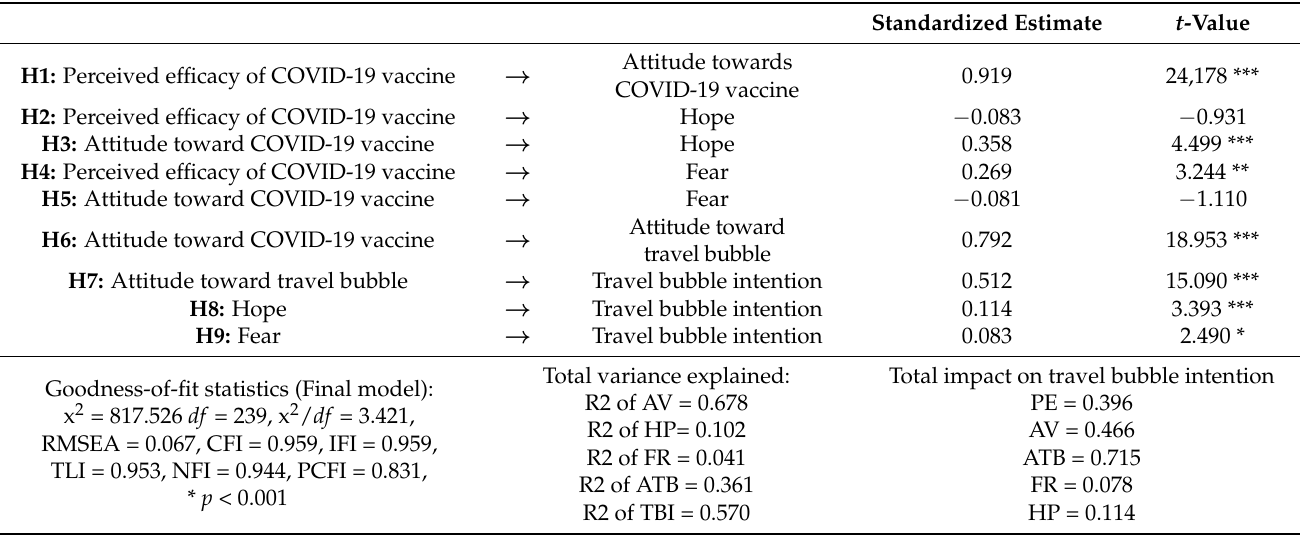
Table 3. Summary of the structural equation modeling results.